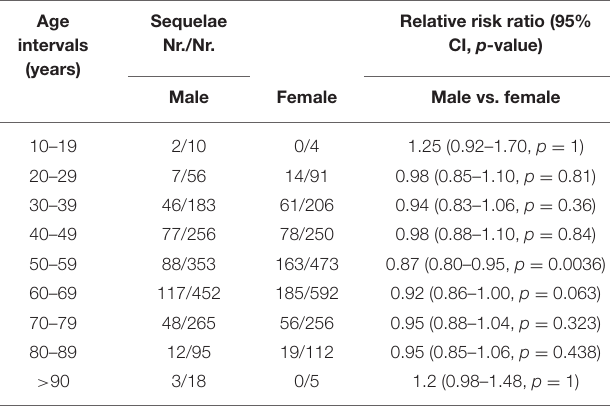
TABLE 4 | Sequelae disposition by 10-year age intervals of discharged coronavirus infectious disease-2019 (COVID-19) patients. Age